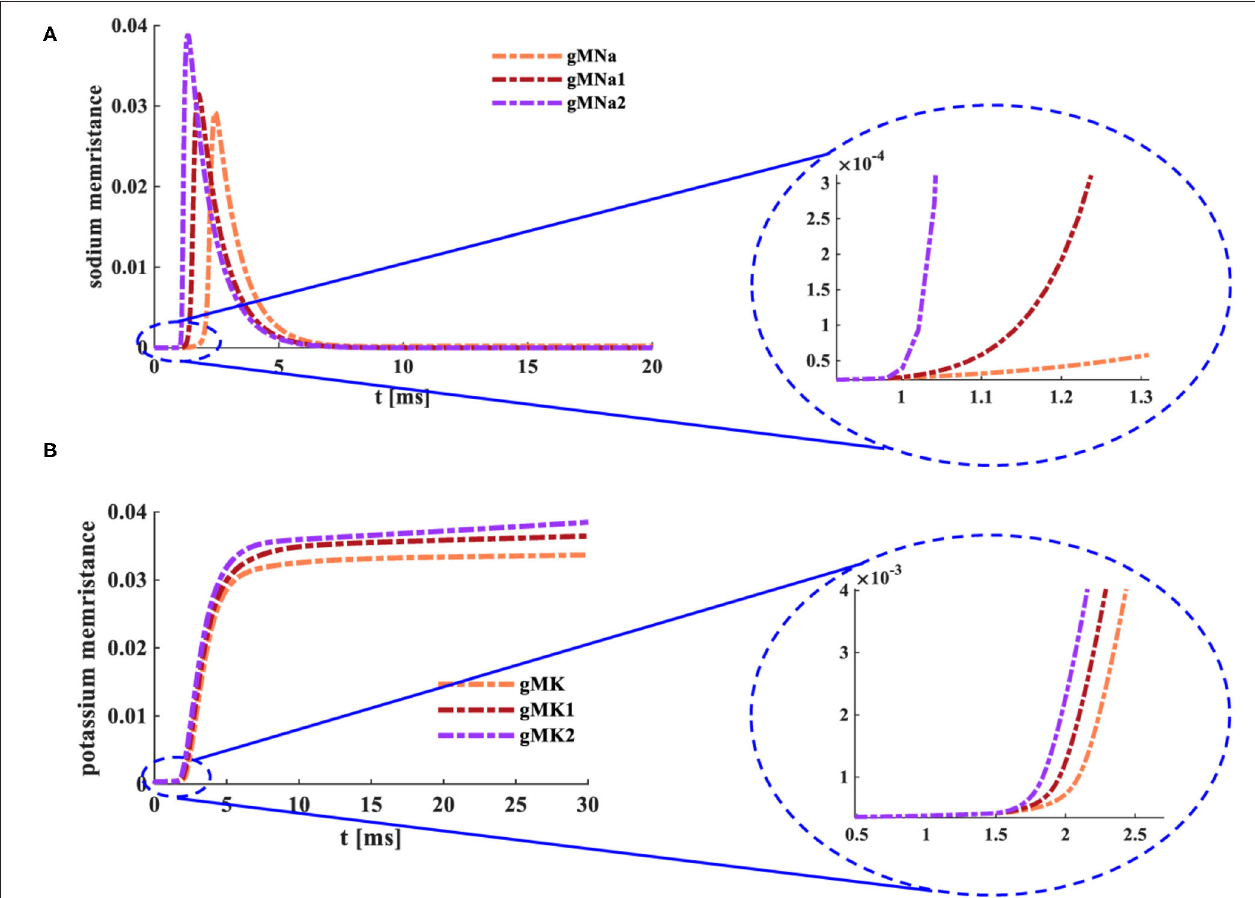
FIGURE 8 | Changes of the memristance under the distinct input currents. (A) The variations of the sodium memristance. (B) The variations of the potassium